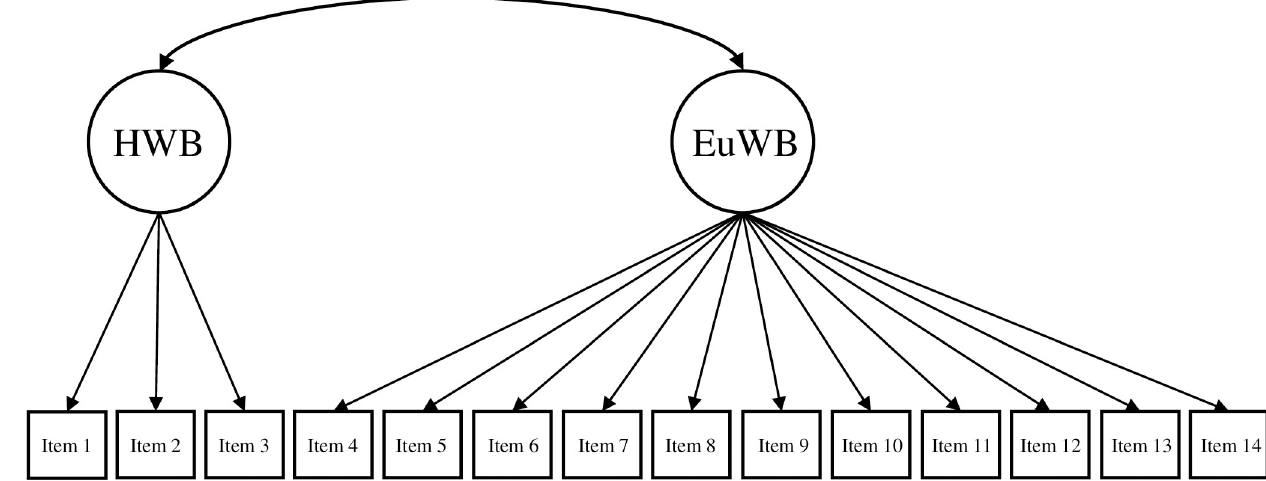
Fig 2. Two-factor model of the MHC-SF. Note . HWB = hedonic well-being, EuWB = eudaimonic well-being.